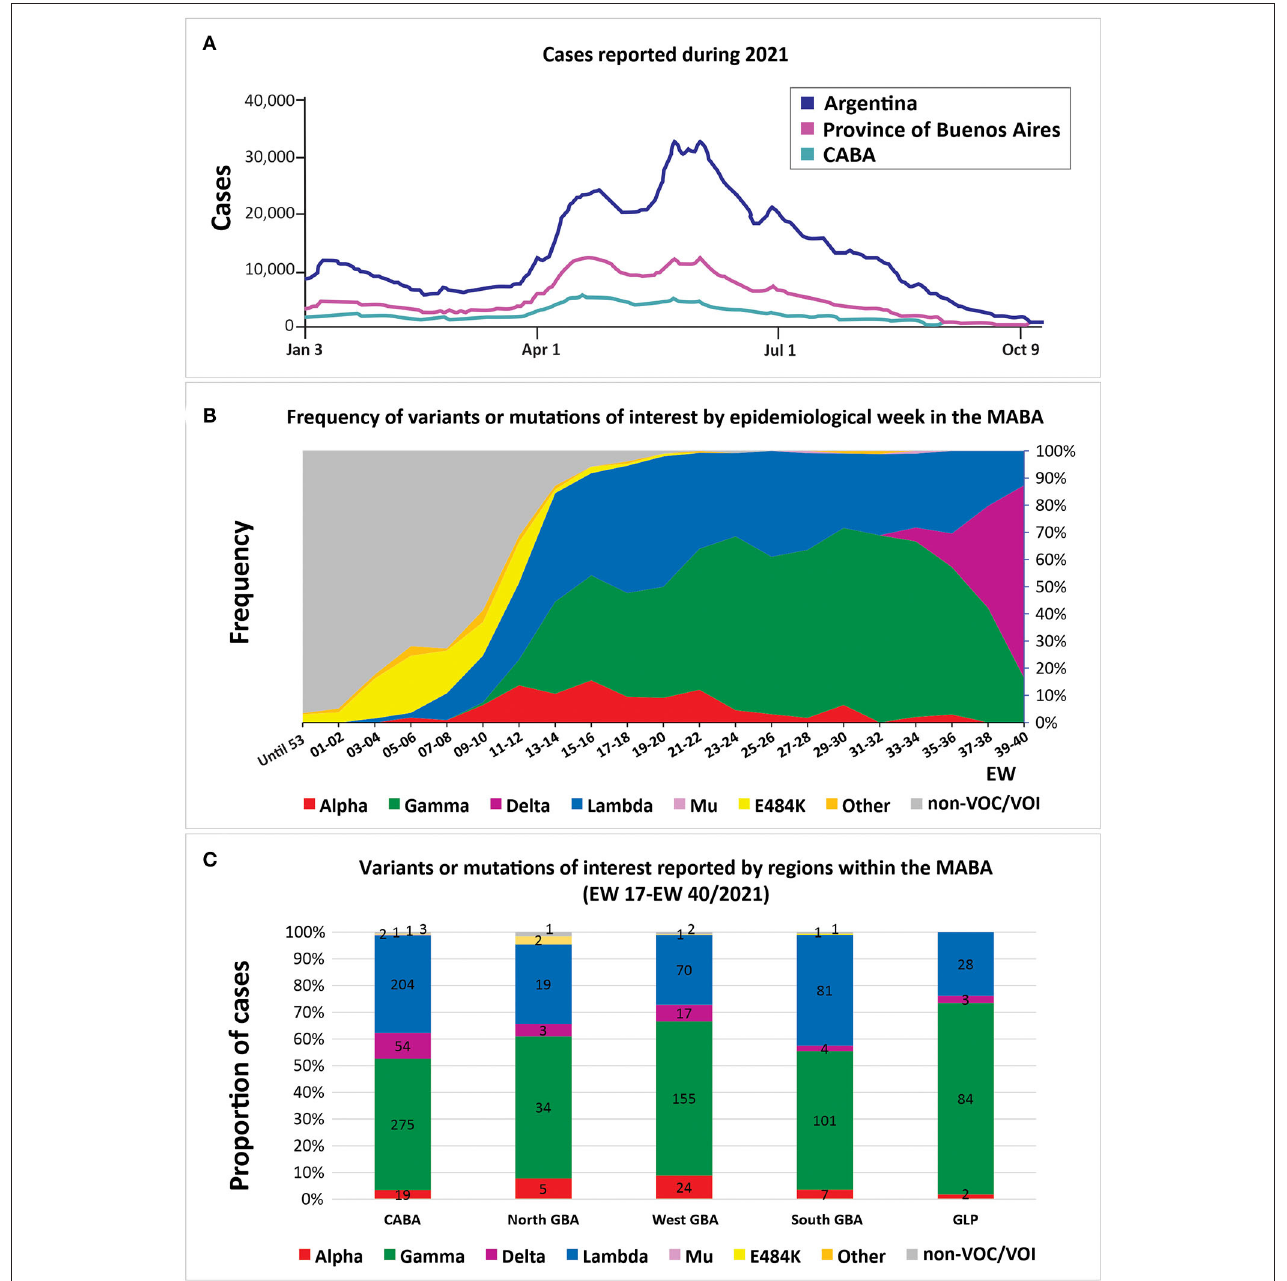
FIGURE 2 | (A) Confirmed cases in Argentina, the city of Buenos Aires (CABA) and the province of Buenos Aires in the year 2021. (B) Frequency of SARS-CoV-2 variants and sequences with or without mutations of interest by epidemiological week ( n = 2,625). Only cases from the metropolitan area of Buenos Aires (MABA) that did not present a history of travel or close contact with travelers are included; in cases with registered epidemiological links, only one case was considered representative. (C) The cumulative number of cases between EW 17/2021 and EW 40/2021 of SARS-CoV-2 variants and sequences with or without mutations of interest within the different regions of the MABA: CABA, Great Buenos Aires (GBA), and Great La Plata (GLP). Only cases that did not present a history of travel or close contact with travelers are included; in cases sharing an epidemiological link, only one was included. (A,B) are on the same time scale. Sequencing identification of signature mutations associated with variants Alpha, Beta, Gamma, Delta, Lambda, and Mu. In addition, The surveillance strategy was based on Sanger sequencing complete SARS-CoV-2 genome sequences were obtained of a 970 nt region of Spike encoding amino acids 428–750 from 637 samples using the Quick protocol (10) (9). This region allows the